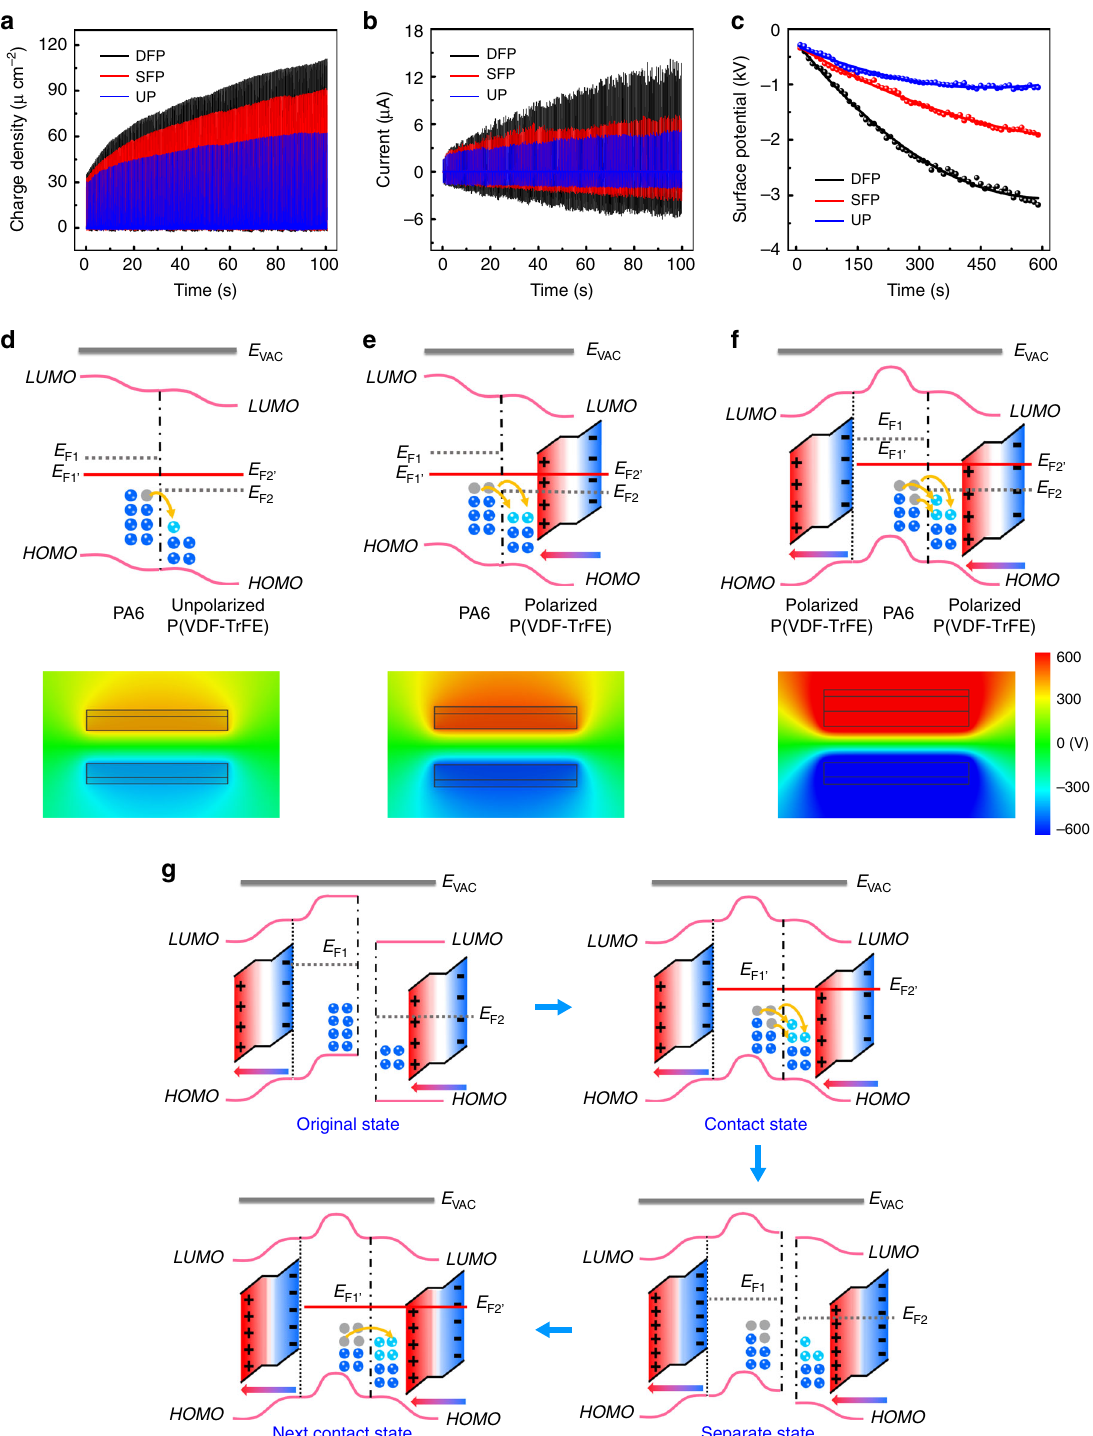
Fig. 2 Working mechanism of the tribo-ferroelectric synergistic electronics. a The output charge density and b short-current of UP, SFP and DFP e-textiles during contact and separation. c The surface potential (tribo-negative materials) versus time of UP, SFP and DFP e-textiles during contact and separation. Surface states model and ANSYS simulation for explaining the effect of ferroelectric polarization on surface charge transfer in d PA6 and unpolarized P(VDF-TrFE), e PA6 and P(VDF-TrFE) with single ferroelectric polarization effect, f PA6 and P(VDF-TrFE) with dual ferroelectric polarization effect during contact and separation. g A surface states model for explaining the tribo-ferroelectric synergistic effect between the ferroelectricity and triboelectric internal electric fi eld when e-textile is in contact and separate state. E F , Fermi level; E VAC , vacuum level; LUMO , the lowest unoccupied molecular orbital; HOMO , the highest occupied molecular orbital. E F1 and E F2 represent the Fermi level (gray dashed line) of PA6 and P(VDF-TrFE) before contact, respectively. E F1 ’ and E F2 ’ represent the Fermi level (red straight line) of PA6 and P(VDF-TrFE) after contact,